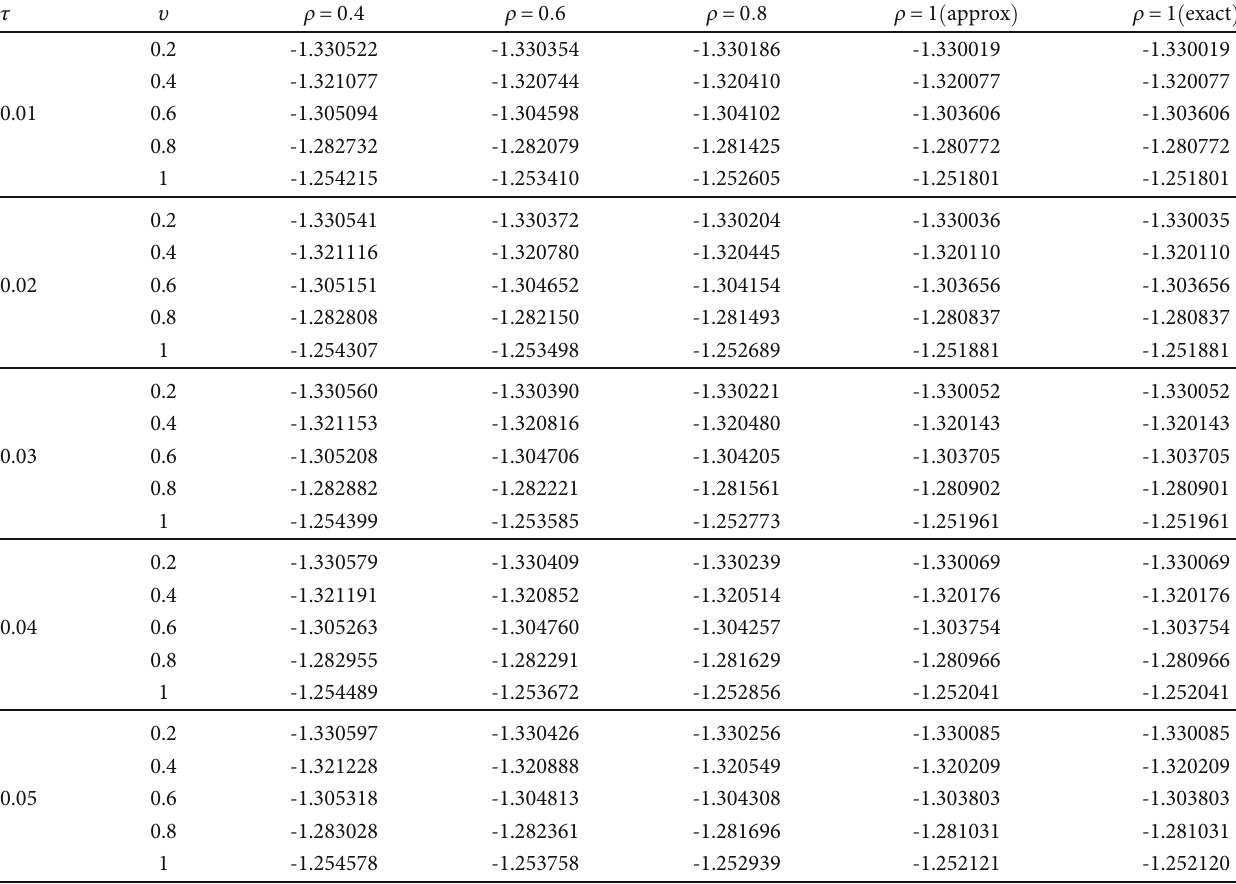
Table 4: Comparison of the exact and proposed method solution at various values of ρ with c = 0 : 5 for problem 2.